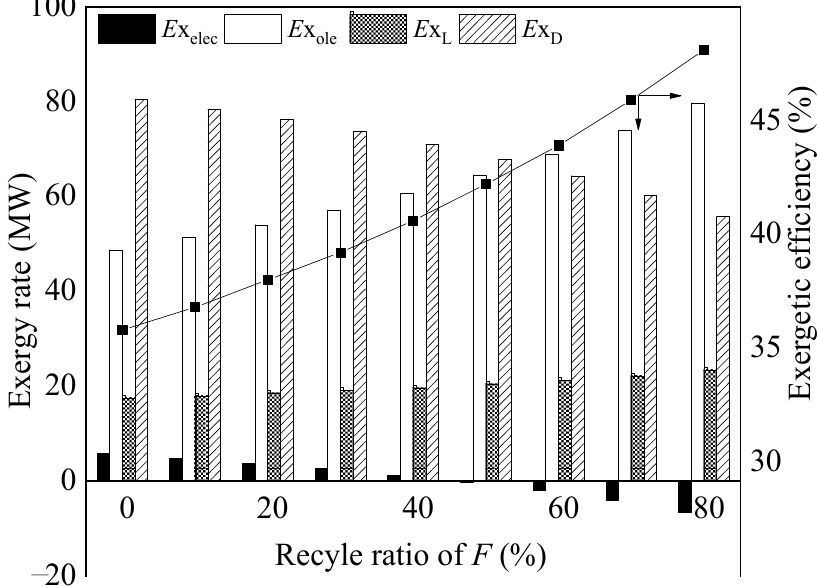
Figure 5. Exergy analysis at the system level with different recycle ratio of synthesis tail gas.